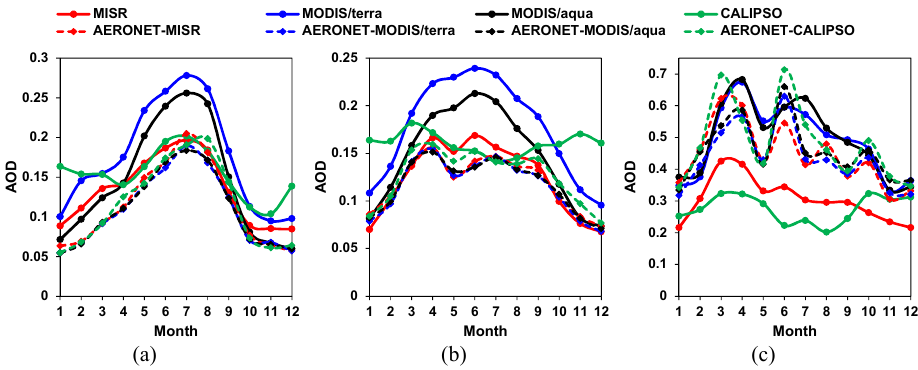
Figure 3. Monthly mean AOD observed by satellites and AERONET averaged across the AERONET sites during 2007–2016 in (a) EUS, (b) WEU, and (c) ECC. The observations from MISR, MODIS/Terra, MODIS/Aqua, and CALIPSO are averaged over 1 ◦ × 1 ◦ grid boxes containing the AERONET sites. The AERONET data are averaged within a 2h window centered on satellite overpass times. The numbers of AERONET sites included in analysis are 28, 54, and 13, in the EUS, WEU, and ECC regions, respectively. As the four sensors overpass a site in different days and different times of day, we separately calculate the AERONET data matched to each sensor (denoted by “AERONET- xxx ”). The AERONET curves matched to different sensors are close in EUS and WEU, partly because there are plenty of sites in these two regions, and the discrepancy due to the sampling issue is thus smoothed out. In contrast, there are only 13 AERONET sites in ECC, so there exists larger discrepancy between the AERONET data matched to different sensors. Note the different scales on the y axes of the